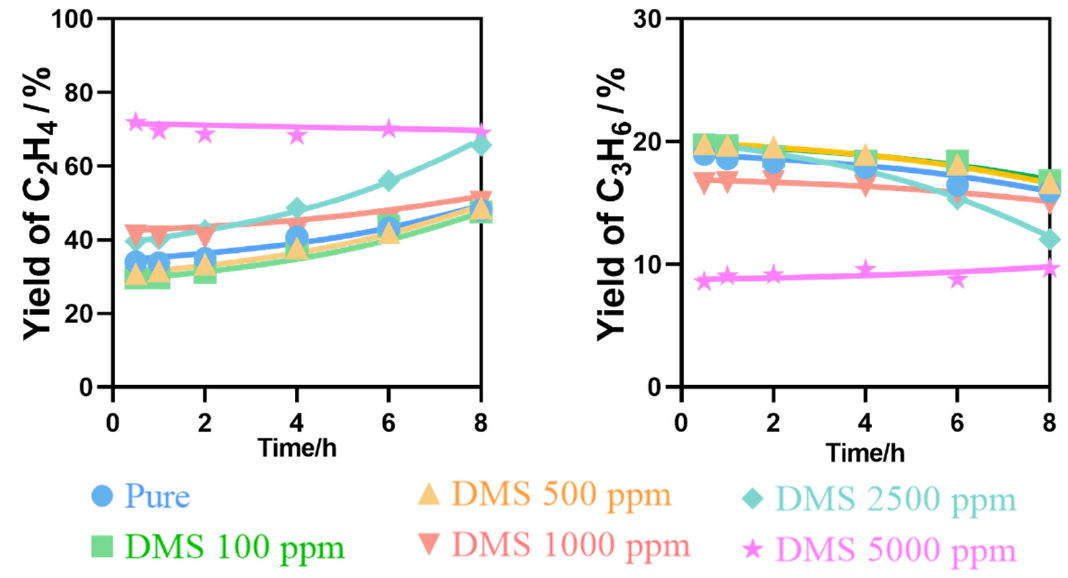
Figure 10. Effect of DMS on catalytic stability of ETO reactions. Temperature, 400 °C; W/F = 0.0025 g/cm 3 · min − 1 .